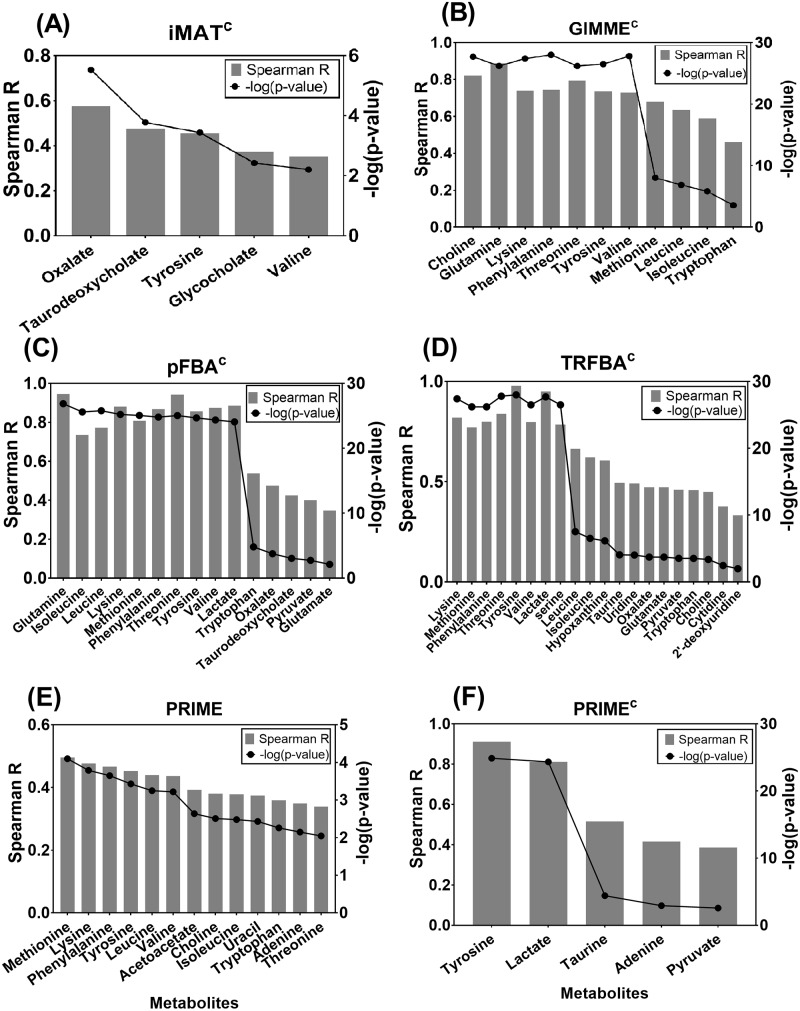
Uptake/secretion rates prediction.Spearman correlation between measured and predicted uptake/secretion flux rates of metabolites for (A) iMATc, (B) GIMMEc, (C) pFBAc, (D) TRFBAc, (E) PRIME, and (F) PRIMEc. Represented p-values were adjusted for False discovery rate (α = 0.05). Only methods with significant predictions are shown.